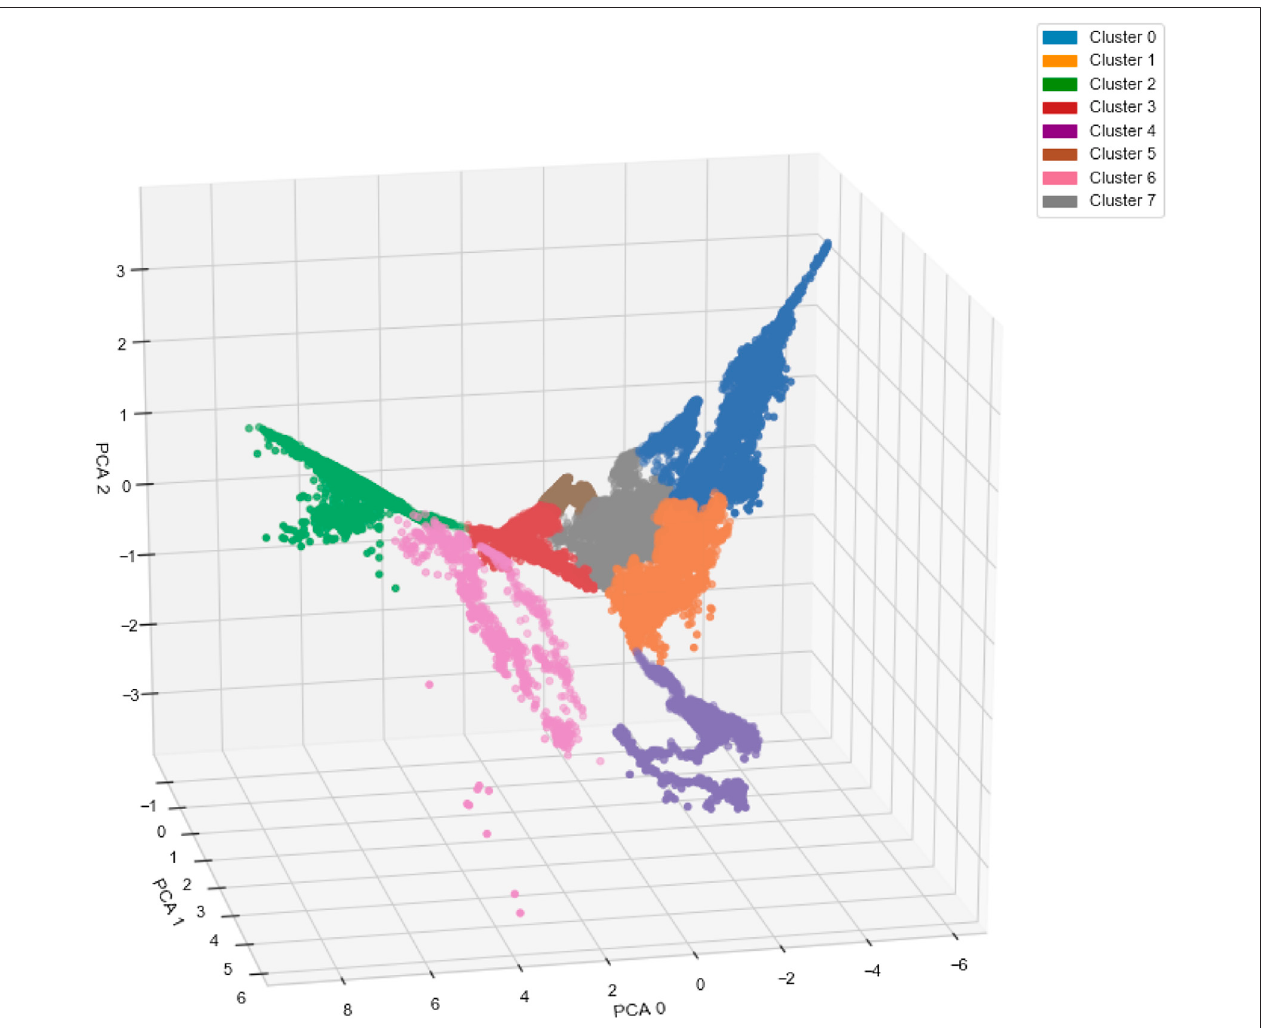
FIGURE 5 | Three-dimensional representation of the magnetotail data after undergoing dimensionality reduction via an autoencoder and principal component analysis (PCA) algorithm. The colors represent the clustering results from the agglomerative clustering algorithm.